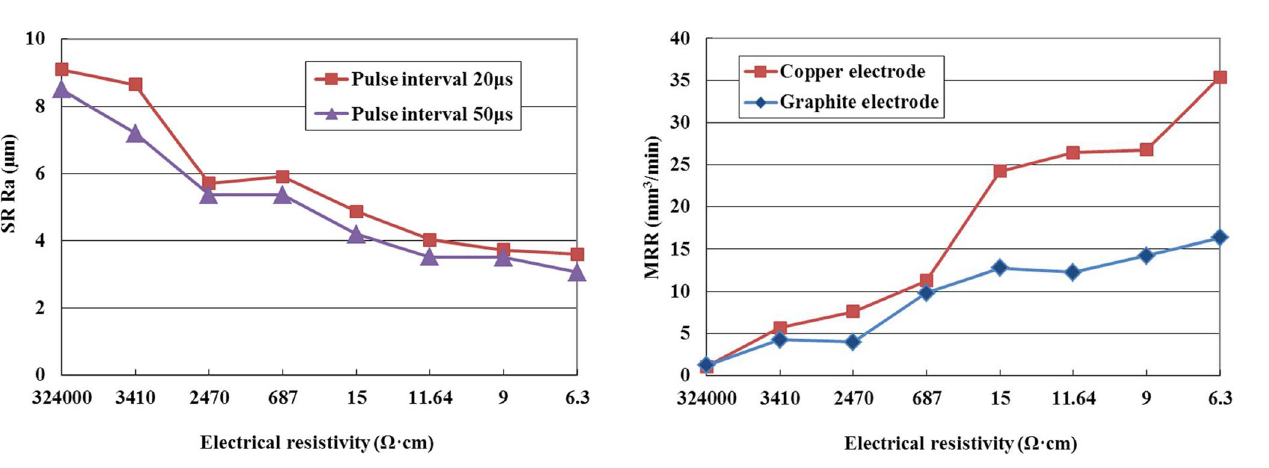
Figure 11. Effect of the electrode material on